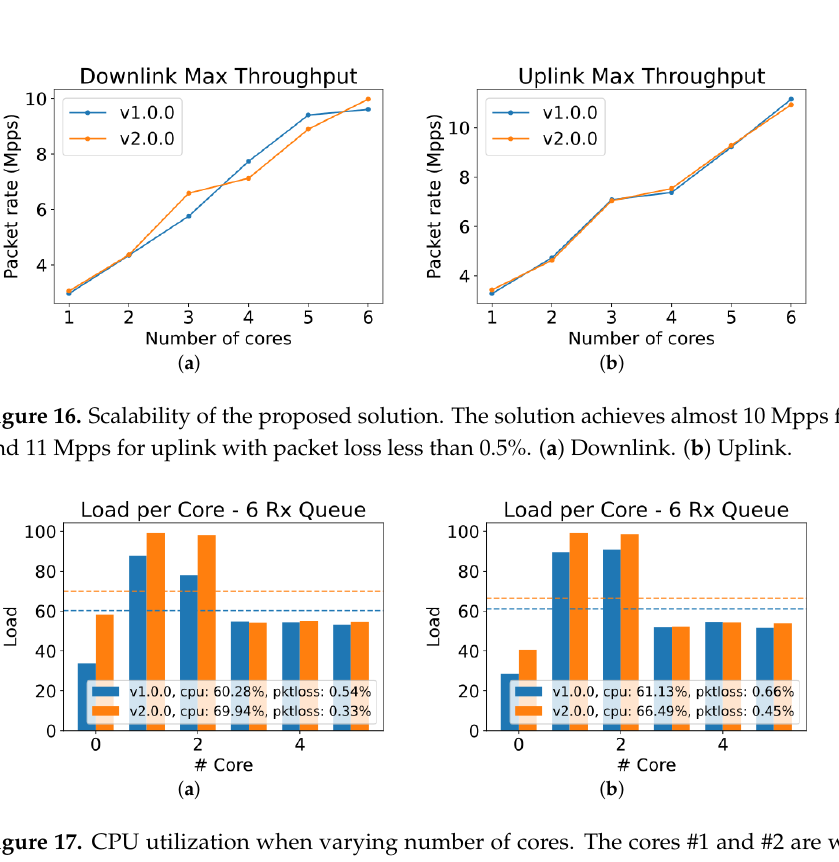
Figure 17. CPU utilization when varying number of cores. The cores #1 and #2 are with a higher CPU utilization. ( a ) Downlink 6 cores. ( b ) Uplink 6 cores.